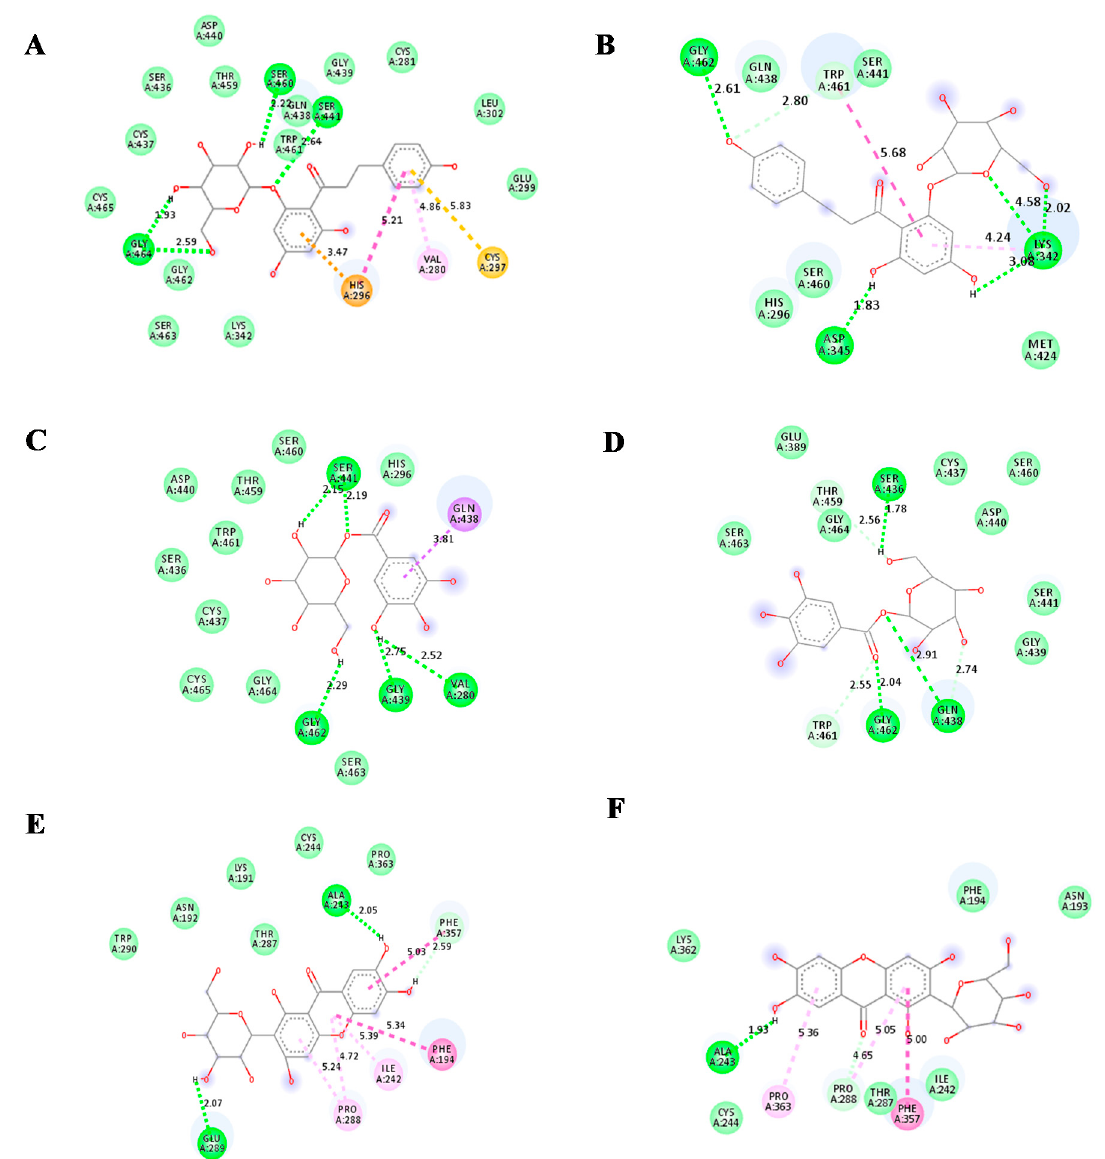
Figure 6. ( A ) Docked phlorizin-TMPRSS2 complex (t = 0), ( B ) phlorizin-TMPRSS2 complex after MD (t = 10 ns), ( C ) Docked glucogallin-TMPRSS2 complex (t = 0), ( D ) glucogallin-TMPRSS2 complex after MD (t = 10 ns), ( E ) Docked mangiferin-TMPRSS2 complex (t = 0) and ( F ) mangiferin-TMPRSS2 complex after MD (t = 10ns).